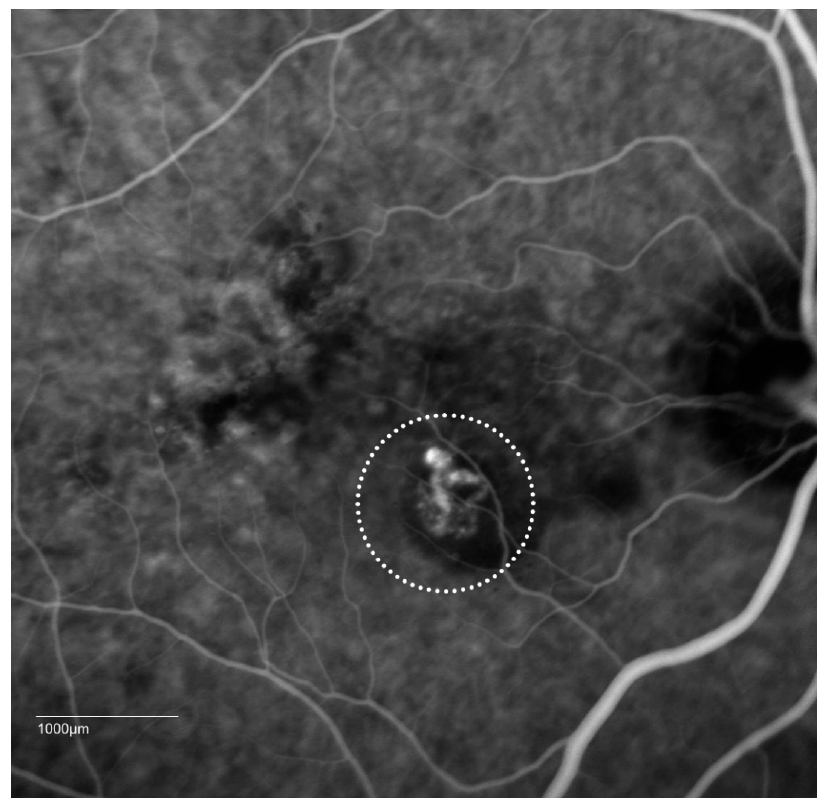
Figure 2. Indocyanine green angiographic (ICGA) patterns of PCV: cluster of grapes configuration (dotted circle) with a hypofluorescent halo. Video angiography sometimes shows pulsatile lesions, which is a definitive sign for the diagnosis of PCV.